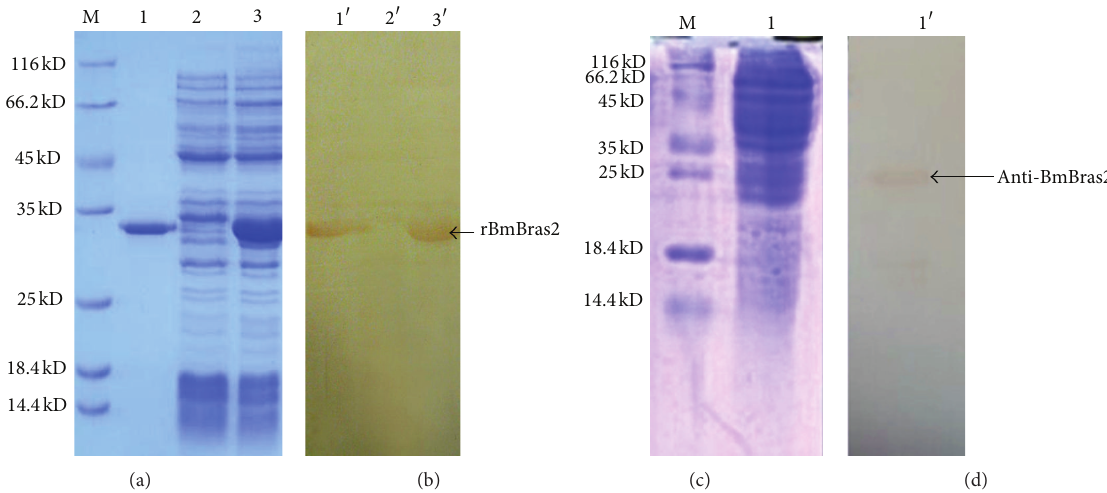
Figure 2: (a) The expression and purification of recombinant BmBras2 were analyzed by SDS-PAGE. (b) The expression and purification of recombinant BmBras2 were analyzed by Western blotting. M, protein mass marker; 1, purified recombinant protein by Ni-NTA superflow cartridges; 2, the lysate of E. coli Rosetta with pET-28a (+)- BmBras2 without induction; 3, the lysate of E. coli Rosetta with pET-28a (+)- BmBras2 after IPTG induction. (c) The lysate of Bm5 was analyzed by SDS-PAGE. (d) The Bm5 cells were collected for western bolt with anti-BmBras2. (Bm5 cells were seeded at 1 × 10 5 cells per flask in culture flask and cultured for three days at 37 ∘ C in a 5% CO 2 incubator.) M, protein mass marker; 1, the lysate of Bm5 cells.